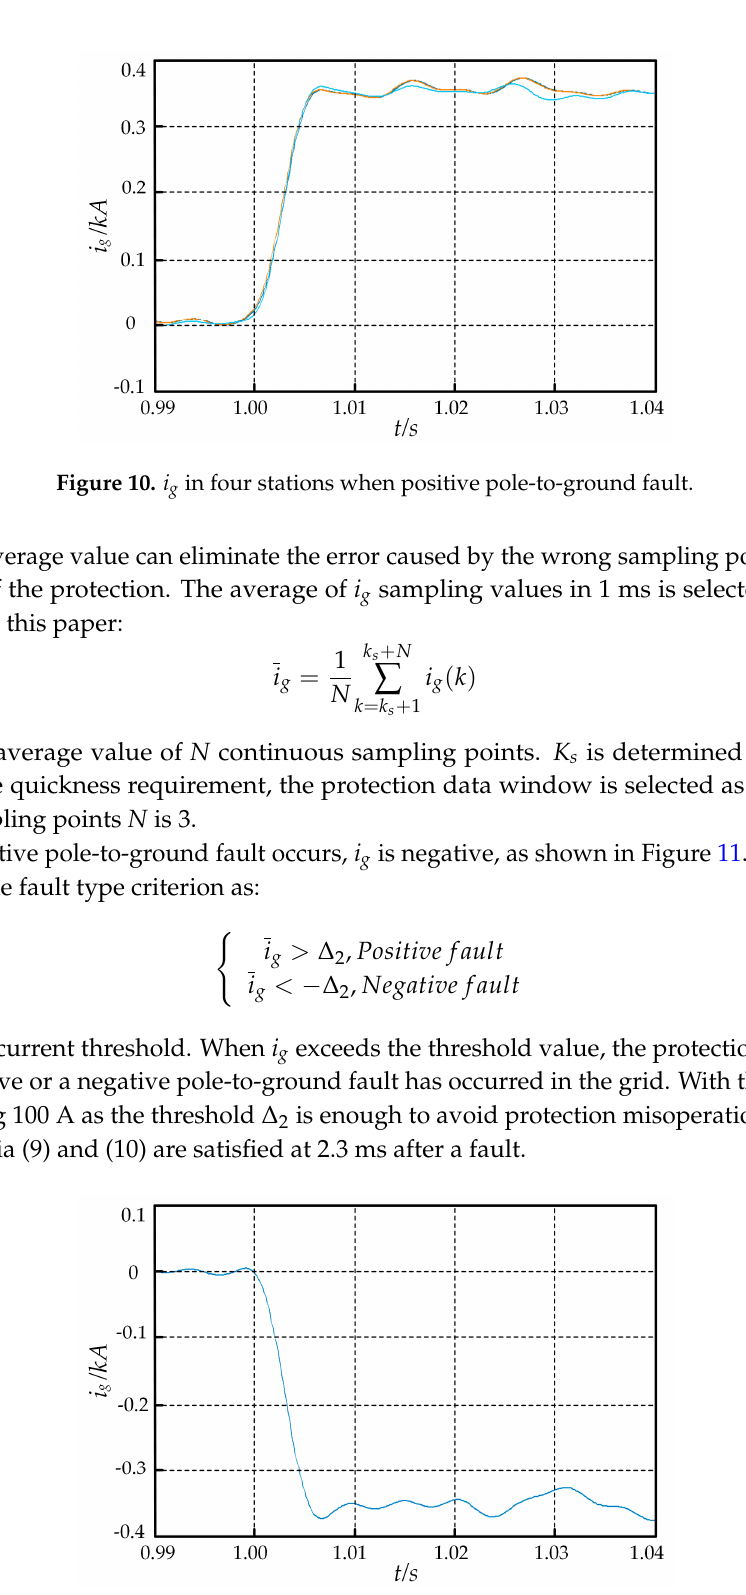
Figure 11. i g in S1 when negative pole-to-ground fault.